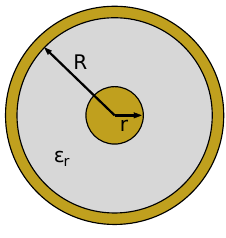
Figure 5. Cross-section of a coax transmission line.